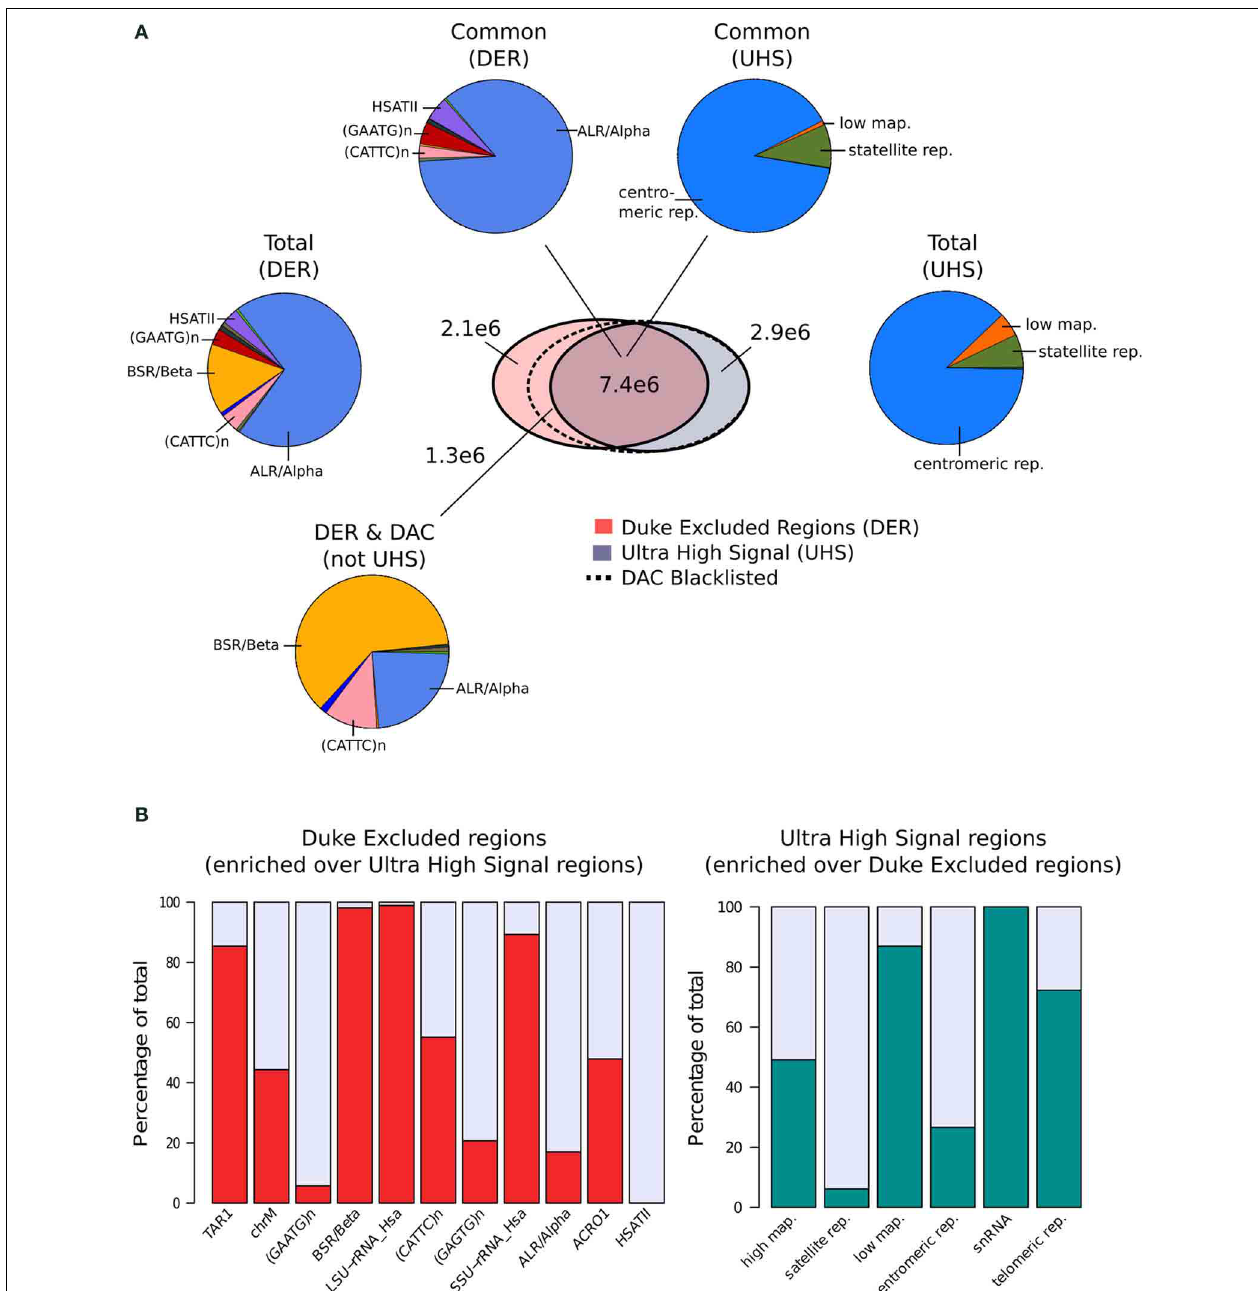
FIGURE 1 | (A) The venn-diagram represents the genomic overlap between DAC consensus, UHS, and DER blacklists. Pie charts show the proportions of blacklist classes contained within overlapping and unique regions of the DAC